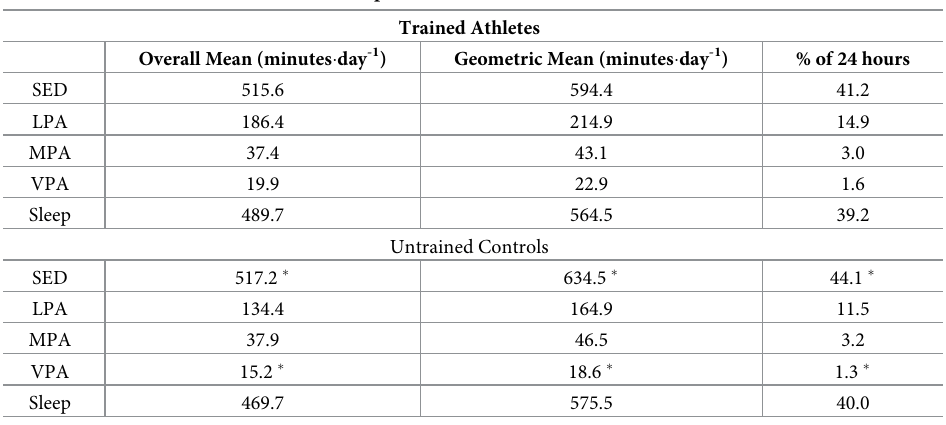
Table 2. Geometric means for the whole